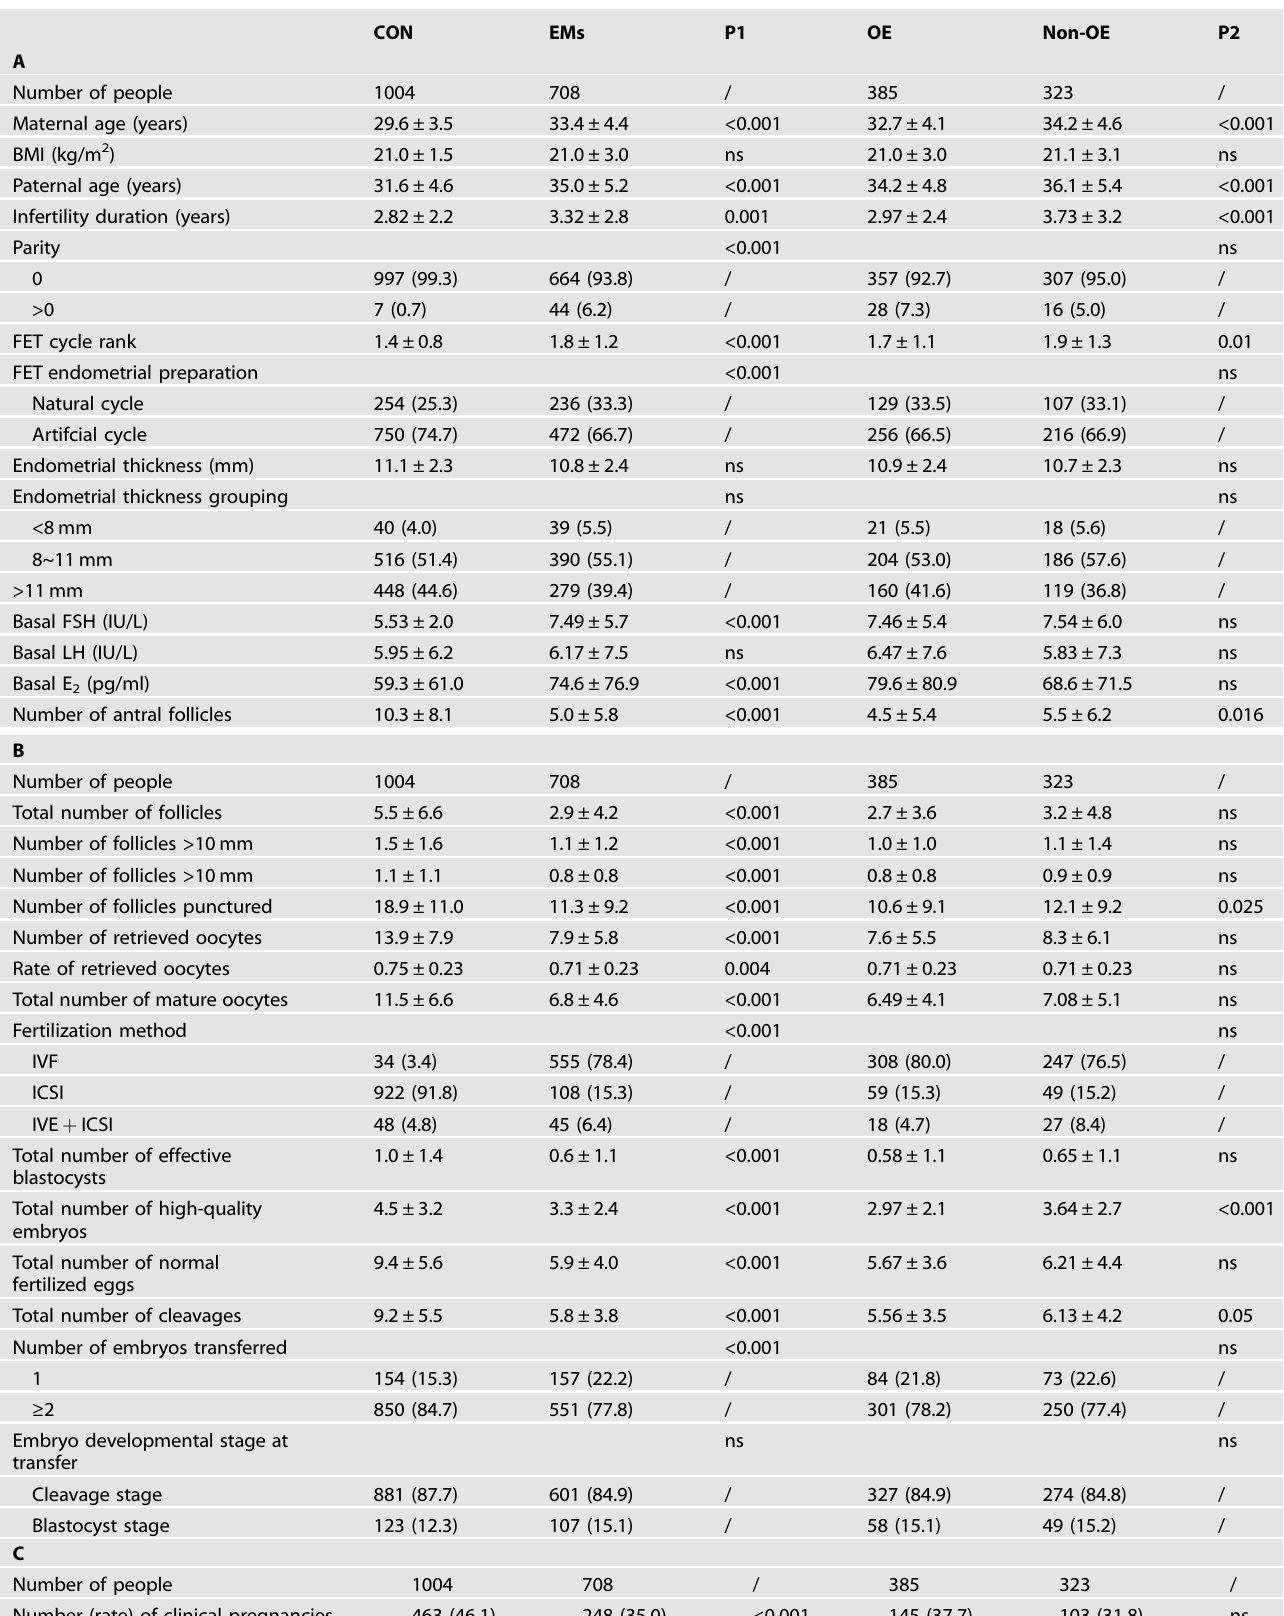
Table 1. A Characteristics of baseline data, B oocyte retrieval cycle and embryo transfer index, and C neonatal outcomes. CON EMs P1 OE Non-OE